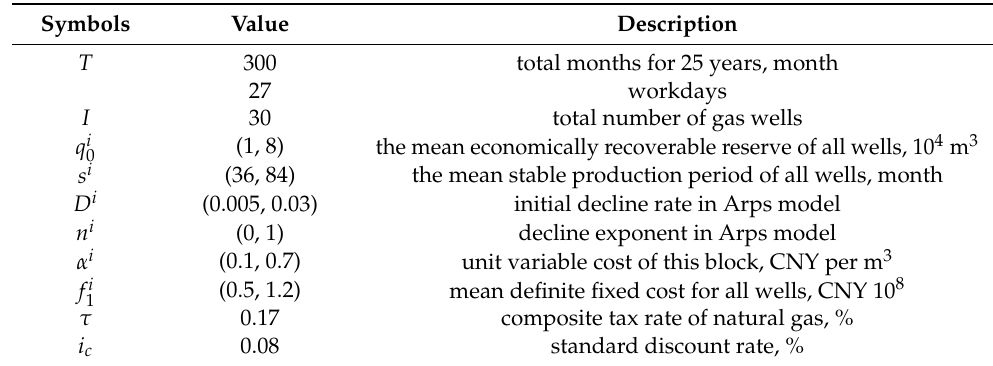
Table 1. Parameter list of economic evaluation model.